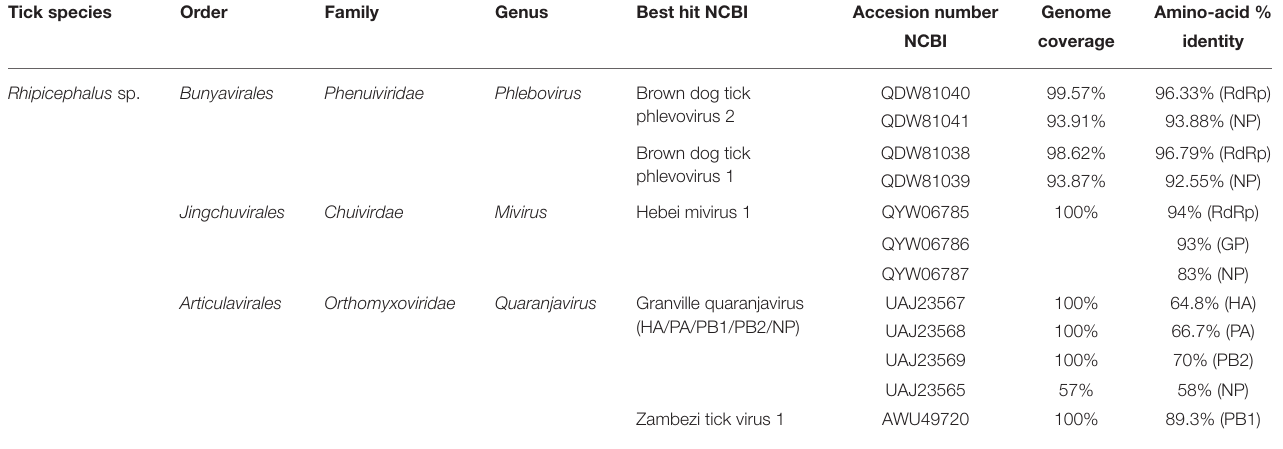
Rhipicephalus sp.